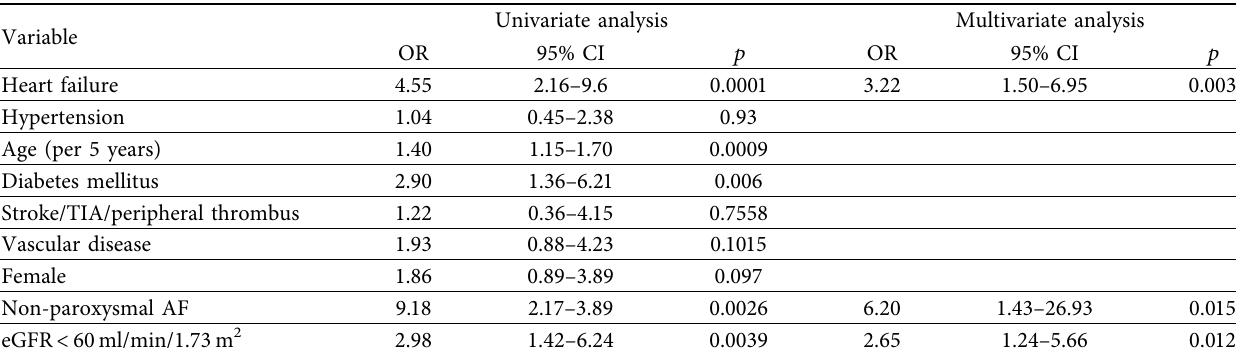
Table 4: Univariate and multivariate analysis of predictive factors for LAAT in patients treated with dabigatran. Univariate analysis Multivariate Variable